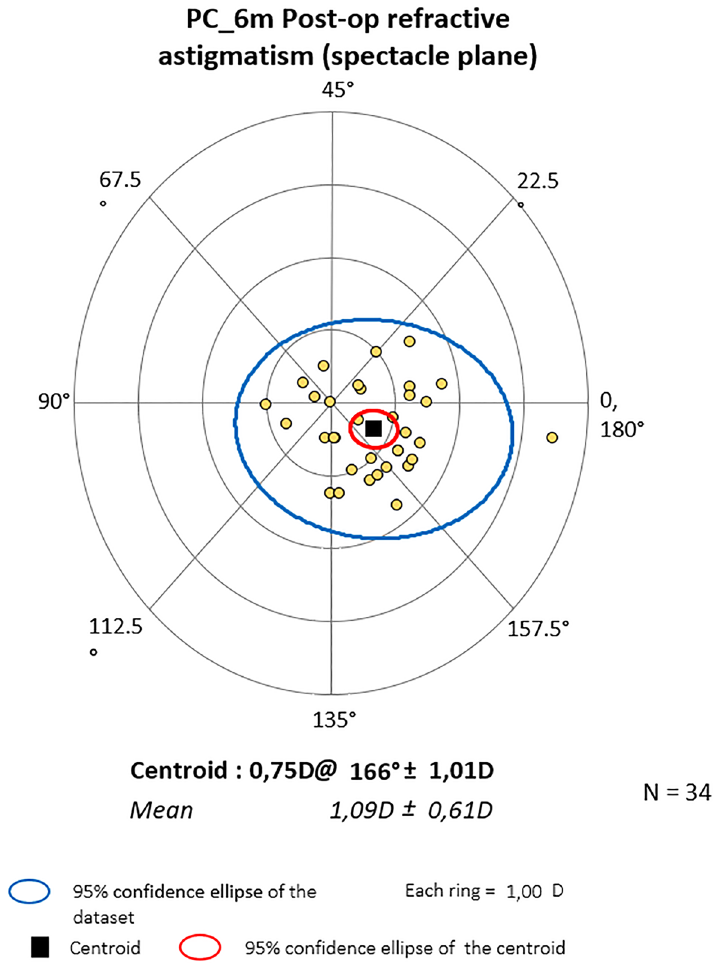
Figure 4. Astigmatism on the double angle plot 6 months post-op in PC. The trend is ATR. The yellow dots represent a single subject’s